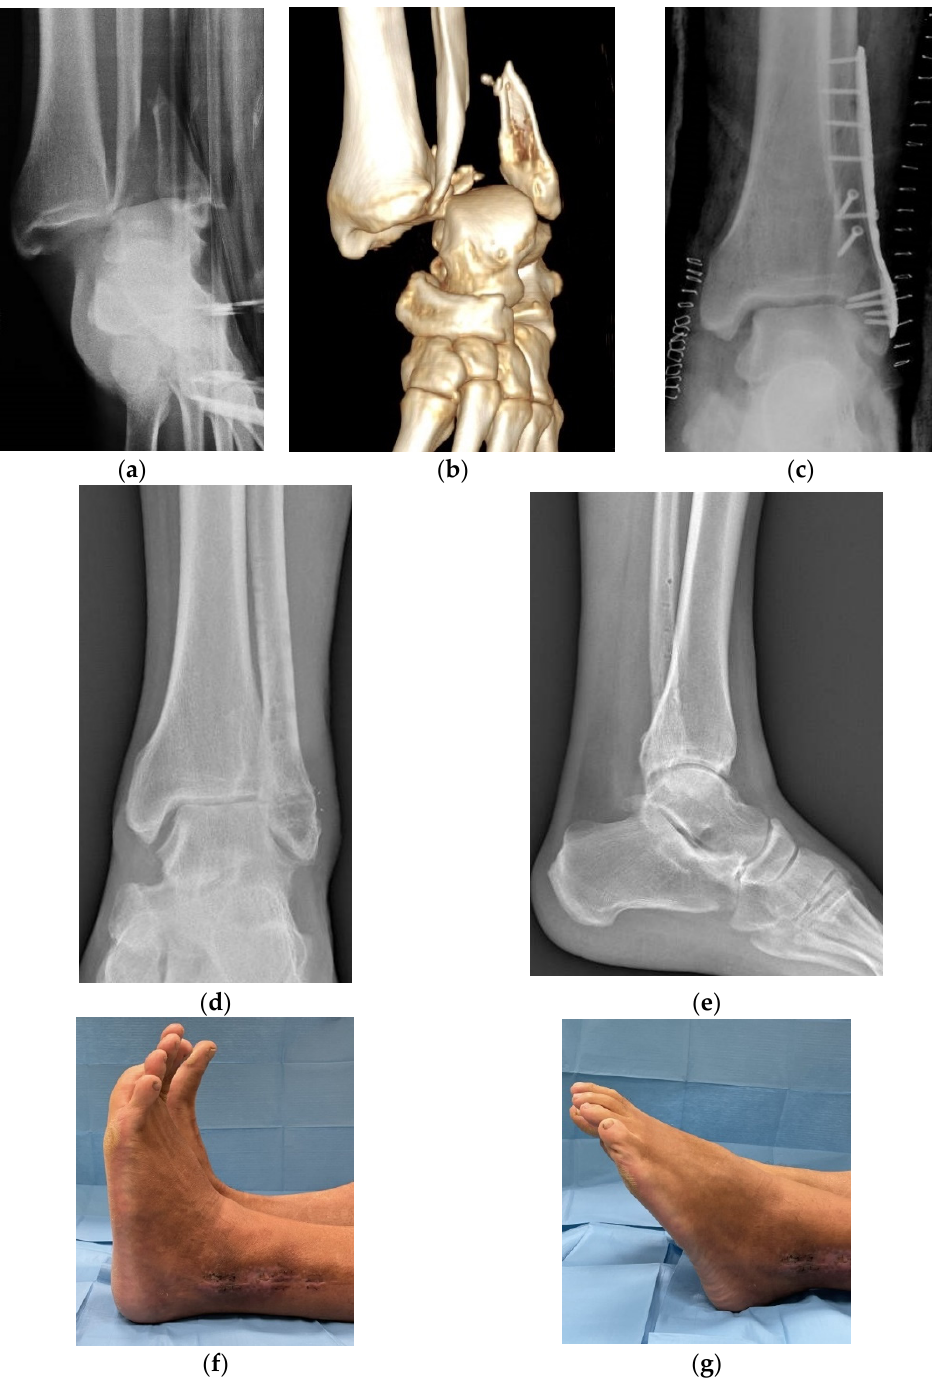
Figure 2. Radiographic examination with a 3D CT scan reconstruction of a fracture-dislocation of the left ankle in a 45 year-old man ( a , b ) treated by open reduction and internal fixation. The post-operative X-rays showed an anatomic reduction of the lesion with a stable osteosynthesis ( c ). At follow up, performed 3.8 years later, after hardware removal, AOFAS was 85 points, in spite of a good range of motion of the ankle and the absence of significant radiographic signs of osteoarthritis (Van Dick grade 0) ( d – g ).